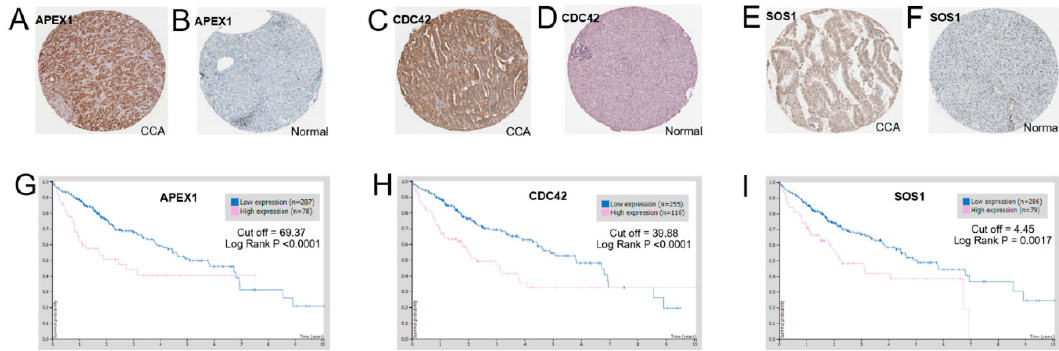
Figure 7. Representative pictures for immunohistochemical detection in CCA and normal tissue, and overall survival time. Image credit: Human Protein Atlas, www.proteinatlas.org, [16]. Image available at the following URL: v20.proteinatlas.org/humancell/ (Accessed on 5 March 2021) ( A ) APEX1 staining of CCA tissue. ( B ) APEX1 staining of normal tissue. ( C ) CDC42 staining of CCA tissue. ( D ) CCD42 staining of normal tissue. (E) SOS1 staining of CCA tissue. ( F ) SOS1 staining of normal tissue. ( G ) APEX1 staining and overall survival time. ( H ) CDC42 staining and overall survival time ( I ) SOS1 staining and overall survival time.